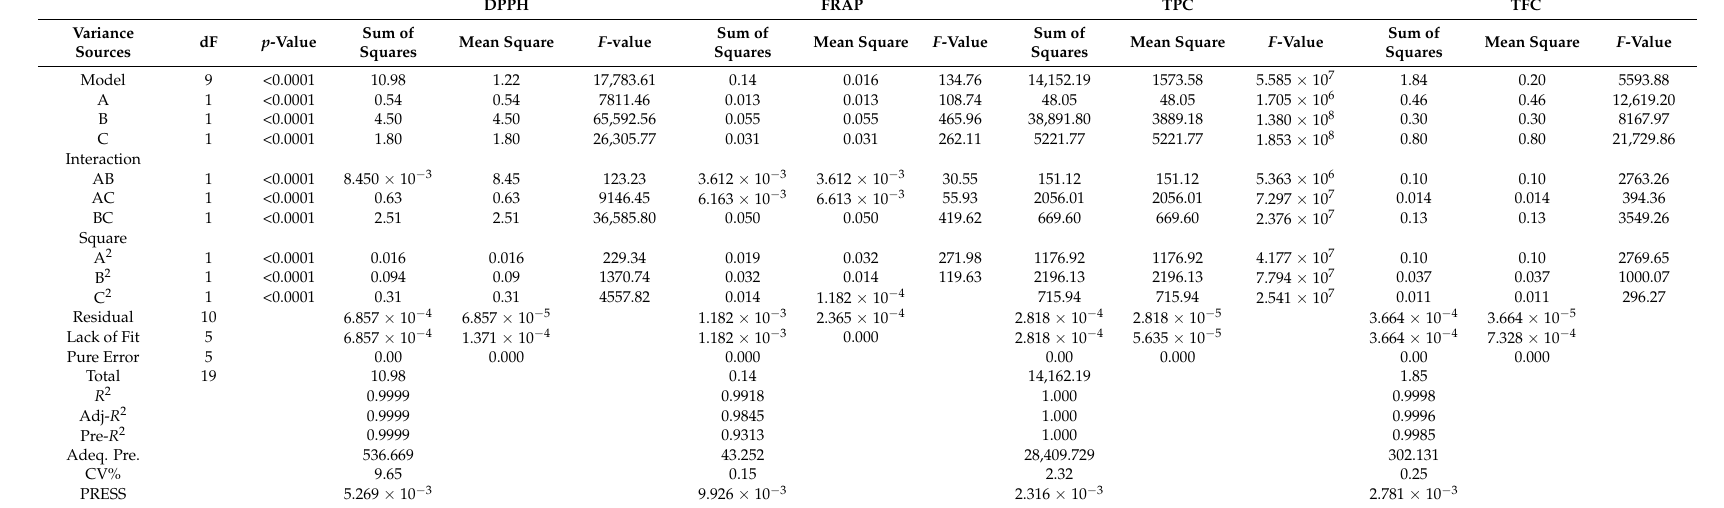
Sum of Squares Mean Square F